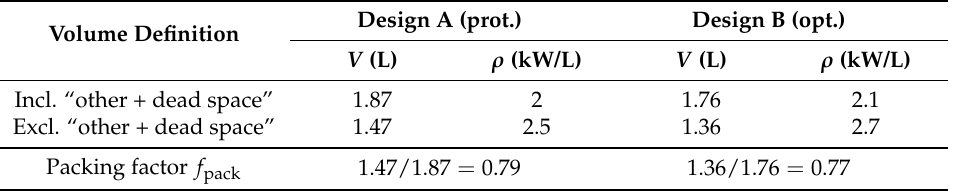
Table 3. Converter power density values (at 3.7 kW, nominal input power).